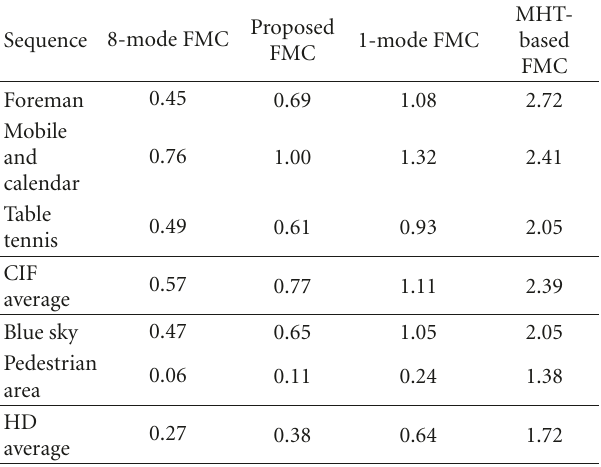
Table 3: Average BD-PSNR(dB) degradation compared with the original